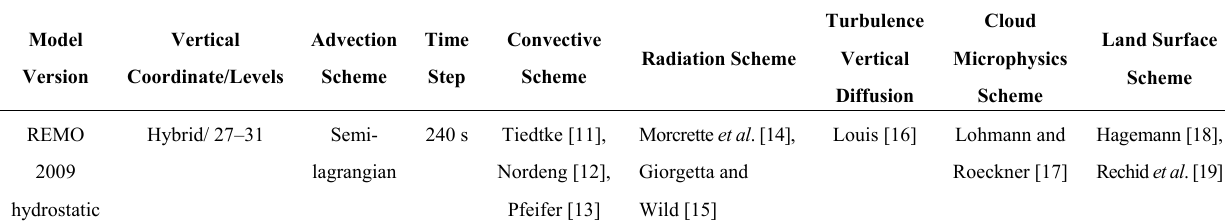
Table 1. Summary of the REMO specifications used for the COordinated Regional Climate Downscaling EXperiment (CORDEX) simulations.